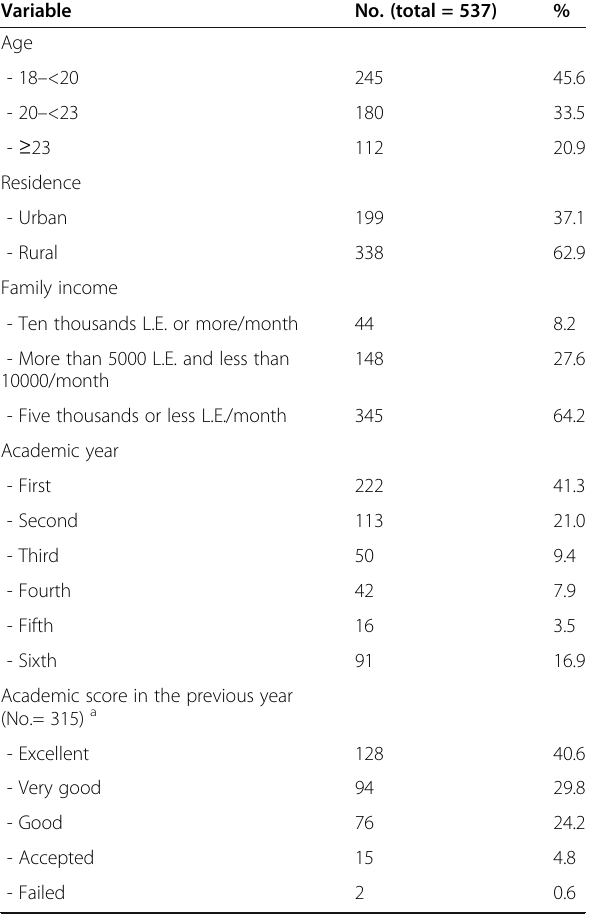
Table 1 Socio-demographic characteristics of male students